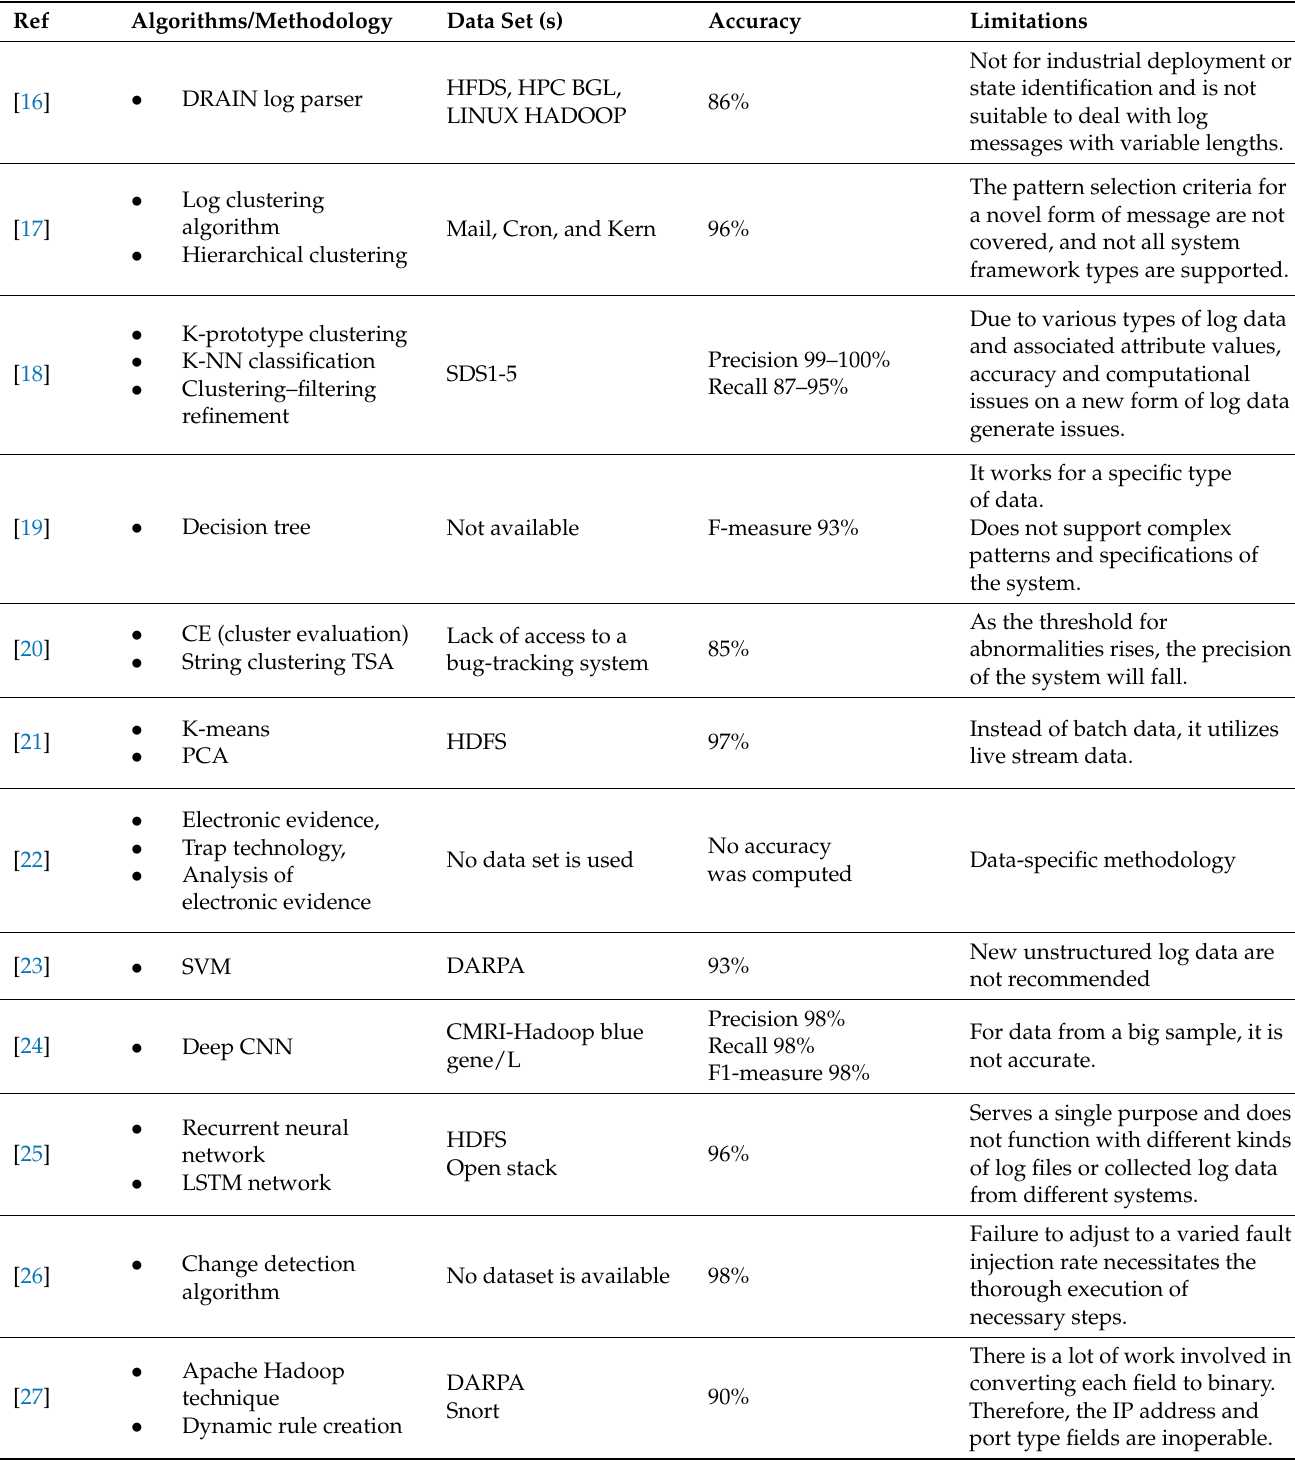
Table 1. Summary of existing